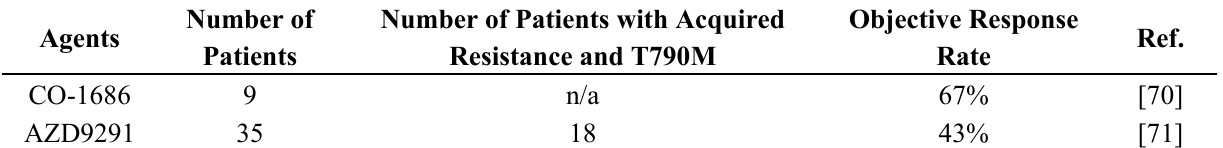
Table 2. Third-generation